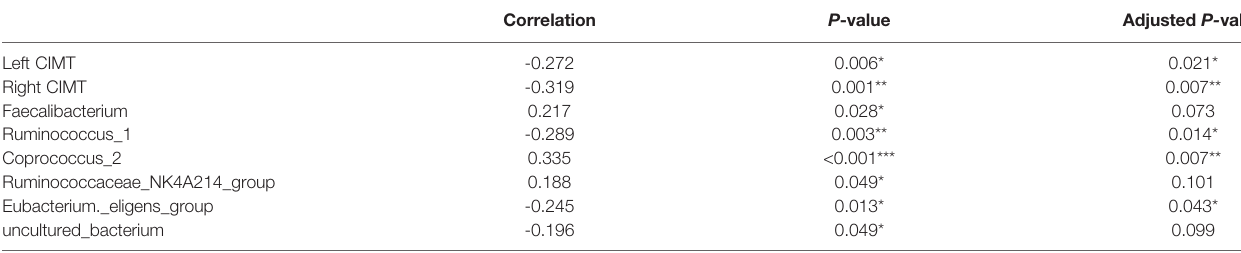
TABLE 2 | The correlation between 25(OH)D and the abundance of genera [left and right carotid intima-media thickness (CIMT)]. Correlation P -value Adjusted P- value Left CIMT